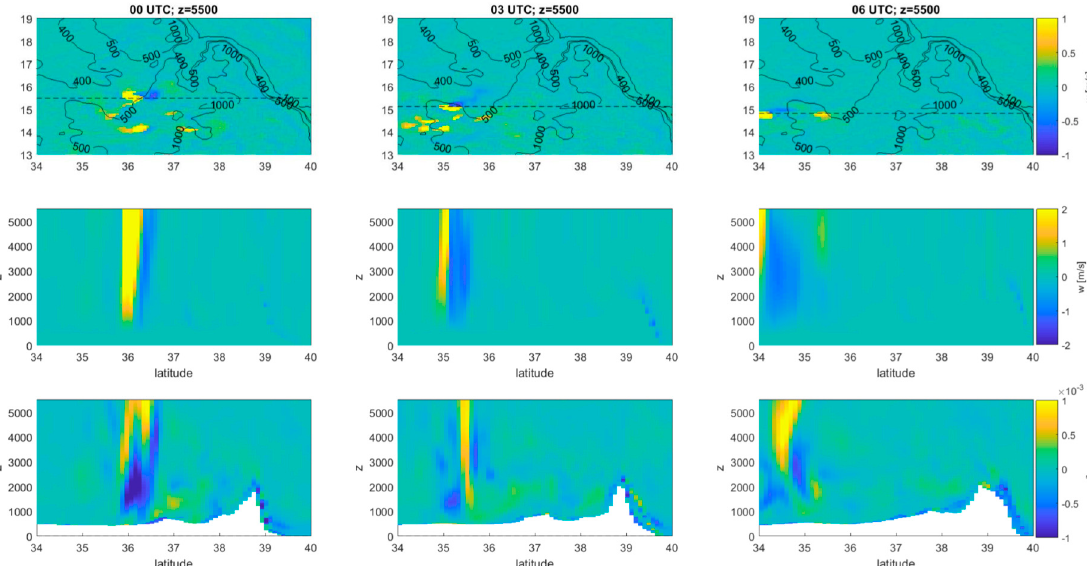
Figure 14. Trajectories initiated within the upstream cell at z = 1000 m (frames ( a – c )) and 1500 m (frames ( d – f )) at the times indicated and over areas where the downward vertical velocity, w, exceeds the value 0.25 m/s.